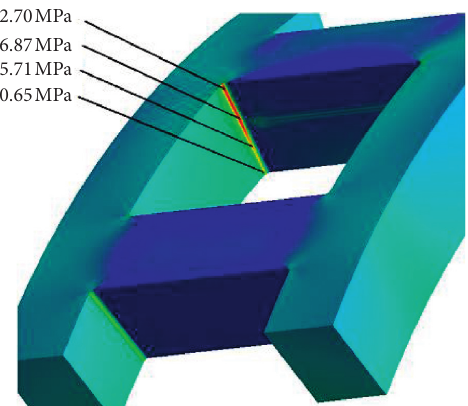
Figure 10: von Mises stress of the connection of crossbeam and side beam at the stage of start-up.